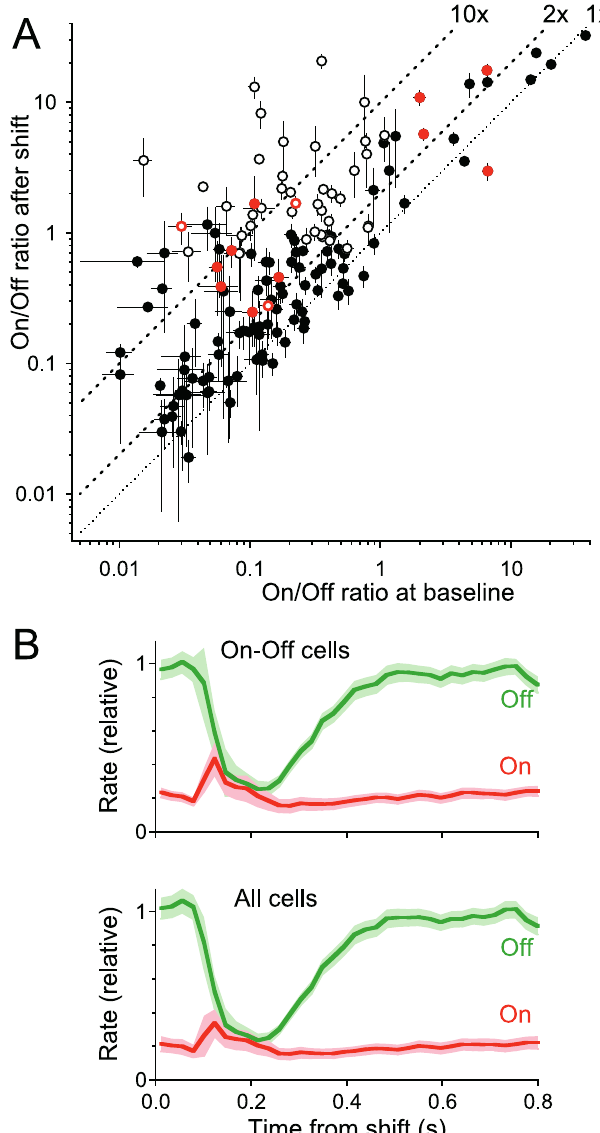
Figure 6. Population Analysis of Peripheral Shift Effects in On-Off Cells (A) Ratio of spikes caused by the On and Off pathways, before and after the peripheral shift. Each point is for one ganglion cell; open symbols represent cells whose linear filter reversed polarity following the shift. Ratios were computed during the 0.1-s period with the largest effect following the image shift (abscissa) and during the baseline period (ordinate, 0.5–0.9 s after the shift). One polarity-reversing cell is not shown because its responses became purely On-type after the peripheral shift. Colored symbols represent neurons in a retina that was subsequently exposed to APB; in APB, all these cells had an On/Off ratio of zero, regardless of the peripheral shift (not shown). Error bars represent one standard deviation uncertainty in the On/Off ratio (see Materials and Methods). (B) Firing rate produced by the On and Off pathways, as a function of time after the peripheral image shift. The firing rate of each cell was normalized to its time-averaged value, and then averaged over the 149 On-Off cells (top) or over all 248 recorded ganglion cells (bottom). Shaded bands report the standard error of the mean.